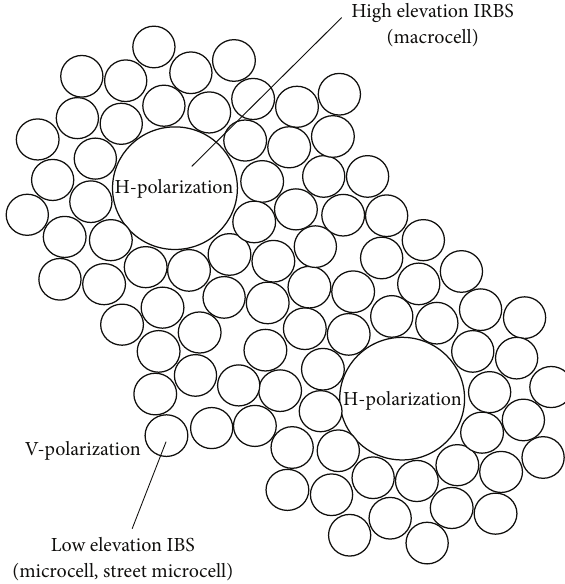
Figure 2: High and low elevation base station antenna arrangement sharing vertical and horizontal polarization.